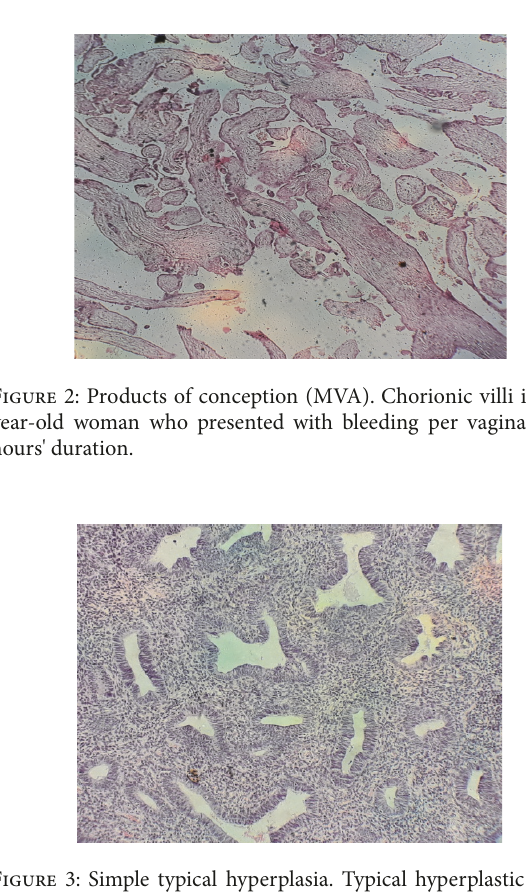
Figure 3: Simple typical hyperplasia. Typical hyperplastic glands in a 42-year-old woman who presented with bleeding per vaginam